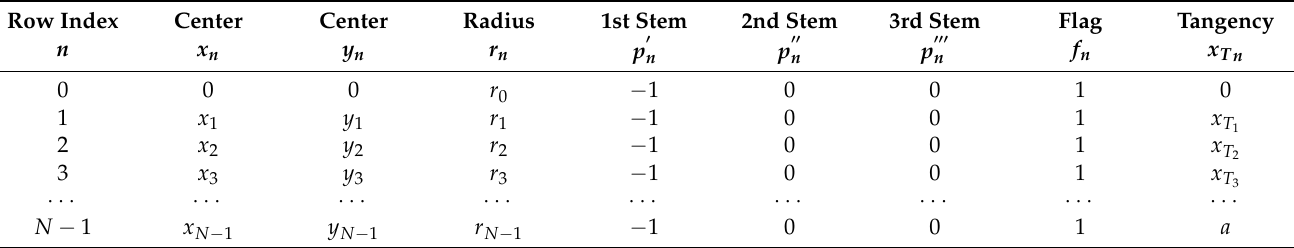
Table 1. Circle array